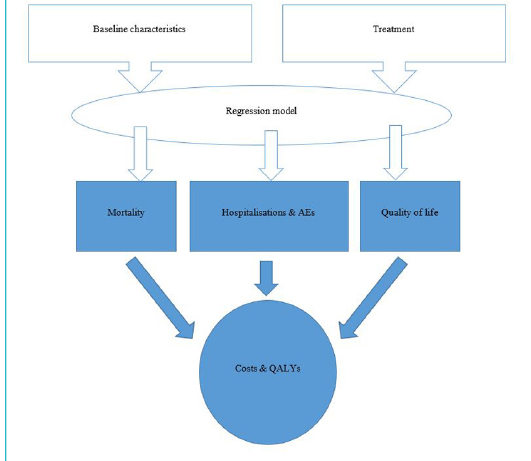
Figure 1: Model structure.AEs = adverse events; QALYs = quality adjusted life